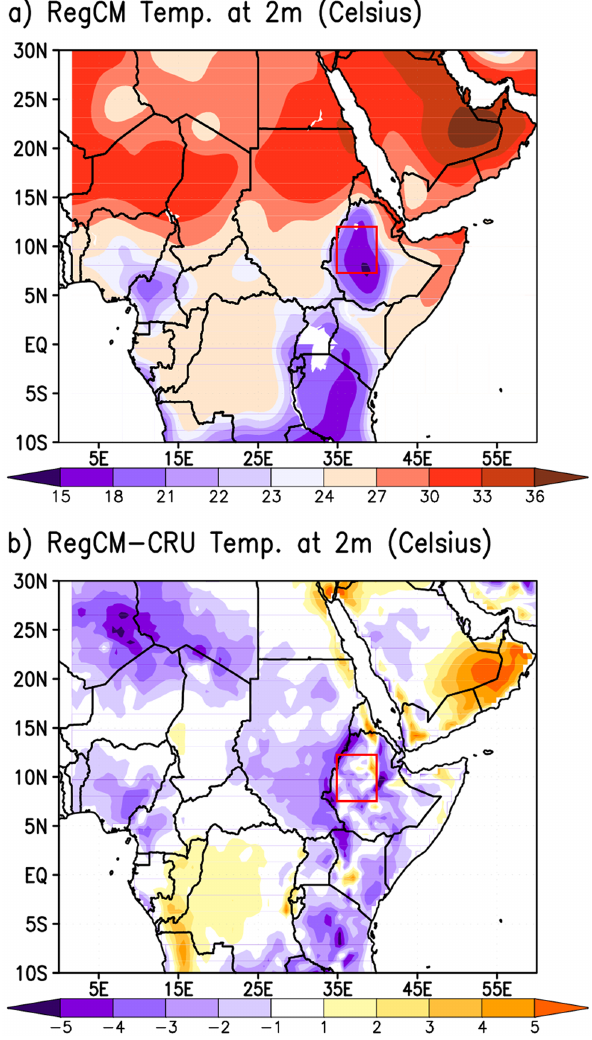
Figure 3. Averaged 2m air temperature (in ◦ C) for JJAS 1982– 2009: (a) Reg-TB, (b) Reg-TB minus CRU. Model data are ensem- ble